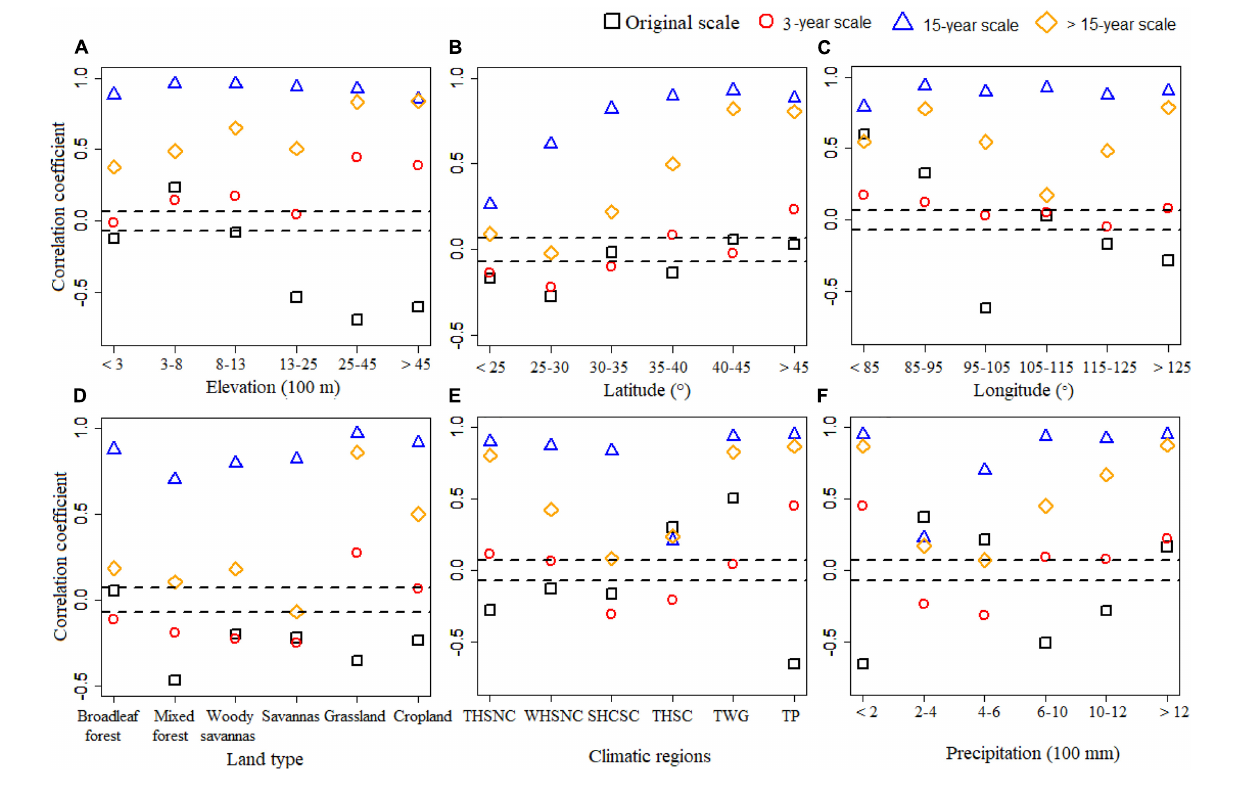
FIGURE 5 | Temporal correlation between NDVI and daily range of temperature (DRT) under different (A) elevation, (B) latitude, (C) longitude, (D) land type, (E) climatic regions, and (F) precipitation at the original scale and multiple temporal scales. NDVI, normalized difference vegetation